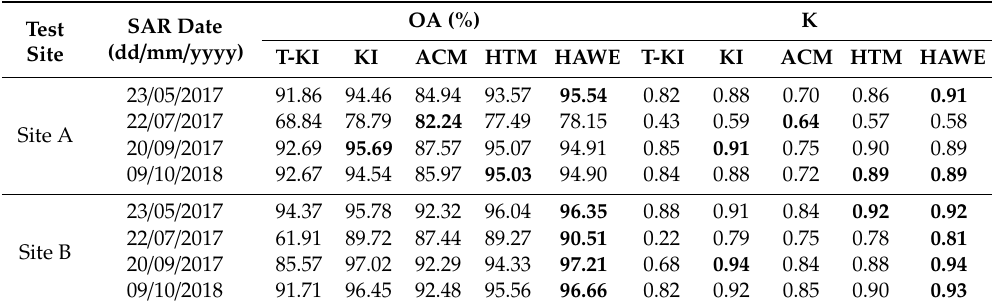
Table 4. The OA and K accuracies of water extraction results derived by di ff erent methods for two selected test sites